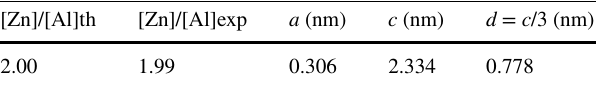
Fig. 1 XRD pattern of the [Zn–Al–Cl] phase prepared by coprecipita- tion Table 1 Experimental [Zn]/[Al] ratio in the solid and its cell param-